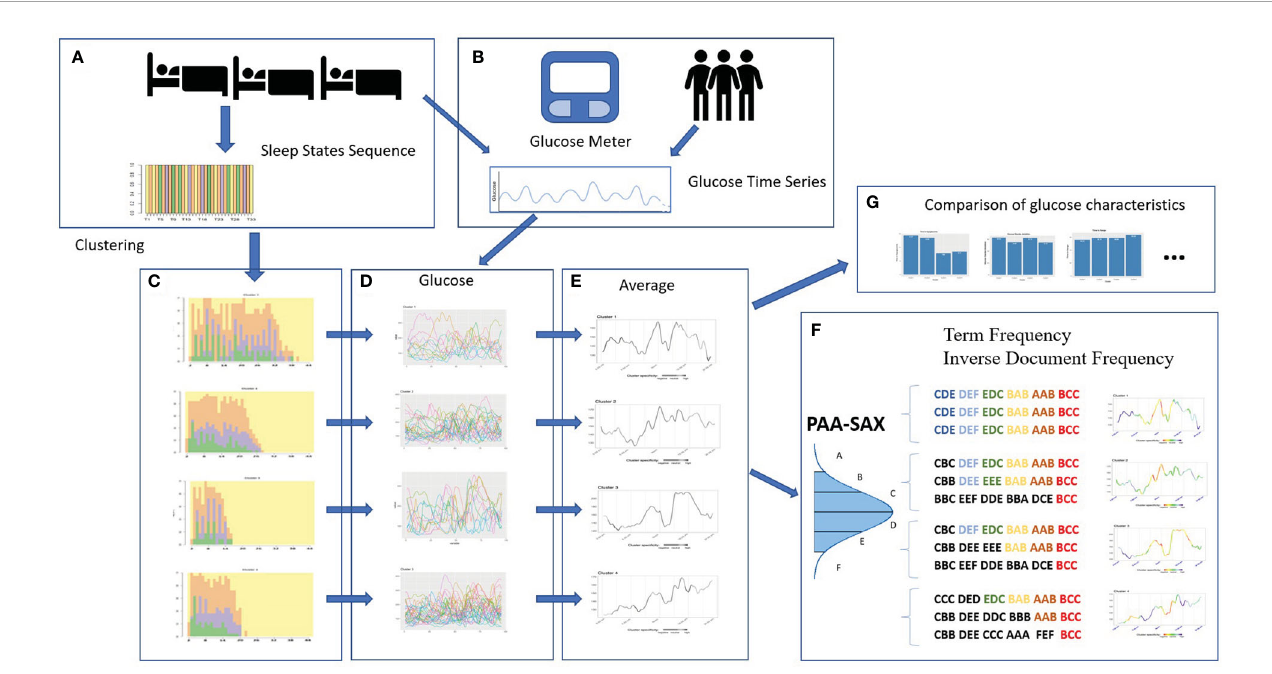
FIGURE 1 Sequence of steps for the development of our study: recording of sleep states and glucose levels (A, B) , clustering (C) , characterizing cluster glucose behavior (D, E) , fi nding speci fi c glucose patterns (F) and comparison of glucose characteristics (G) . 1 https://python- fi